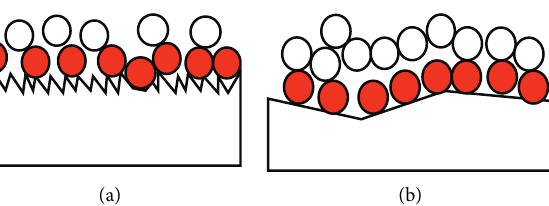
Figure 13: Stress diagram of soil particles on the surface of reinforced materials with different roughness. (a) Soil particles and bamboo reinforcement surface. (b) Soil particles and biaxial geogrid surface.